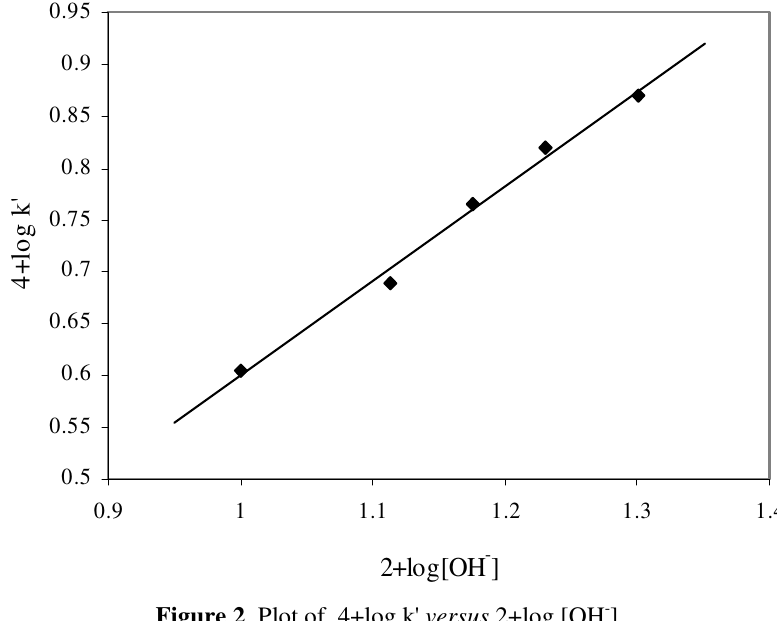
Figure 2 . Plot of 4+log k' versus 2+log [OH -